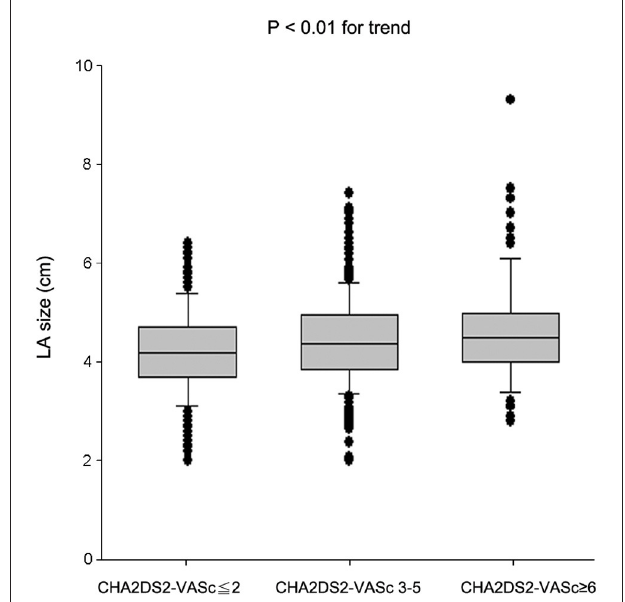
FIGURE 4 | Mean left atrial size for different levels of CHA 2 DS 2 -VASc